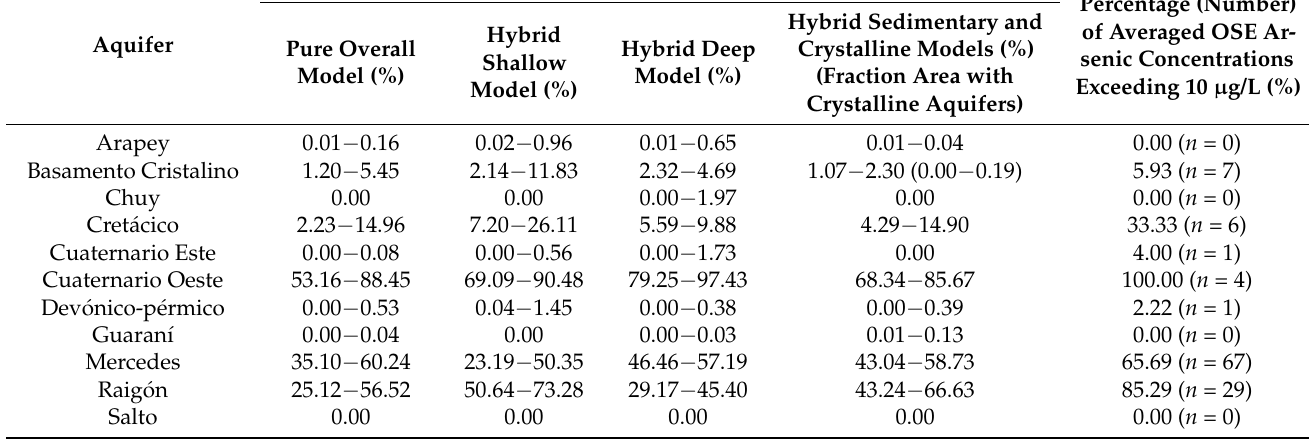
Table 3. Proportion of areas in each aquifer of Uruguay with a high (>10 µ g/L) groundwater arsenic hazard: comparison of modelled and observed values. Modelled high groundwater hazard areas were defined as those with a probability of arsenic concentration greater than 10 µ g/L, exceeding a cutoff value of 0.5 and a specific cutoff value where sensitivity is equal to specificity (overall: 0.71; shallow: 0.67; deep: 0.73; sedimentary: 0.63; crystalline: 0.85). Observed values were based on the proportion of high arsenic (>10 µ g/L) in the aquifers, and the geometric mean of arsenic concentrations was taken within a pixel (1 km 2